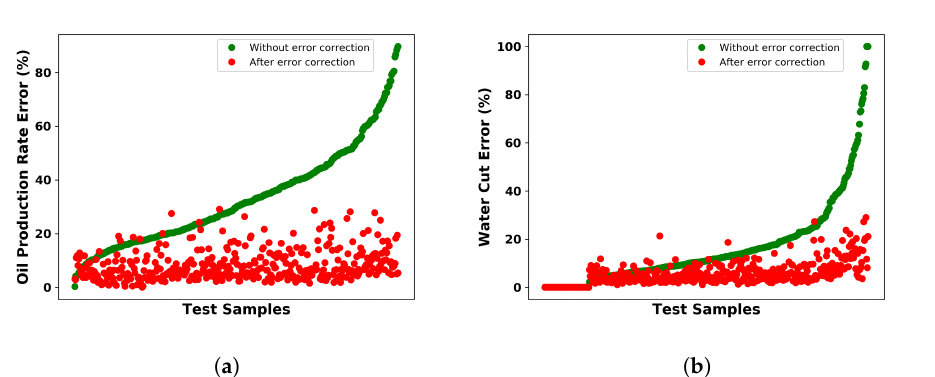
Figure 47. Error in the prediction of ( a ) the oil production rate and ( b ) water cut for all the test cases before and after the error correction of the solutions. Table 11. Heterogeneous reservoir case 2: average accuracy of the oil production rate and water cut for all test